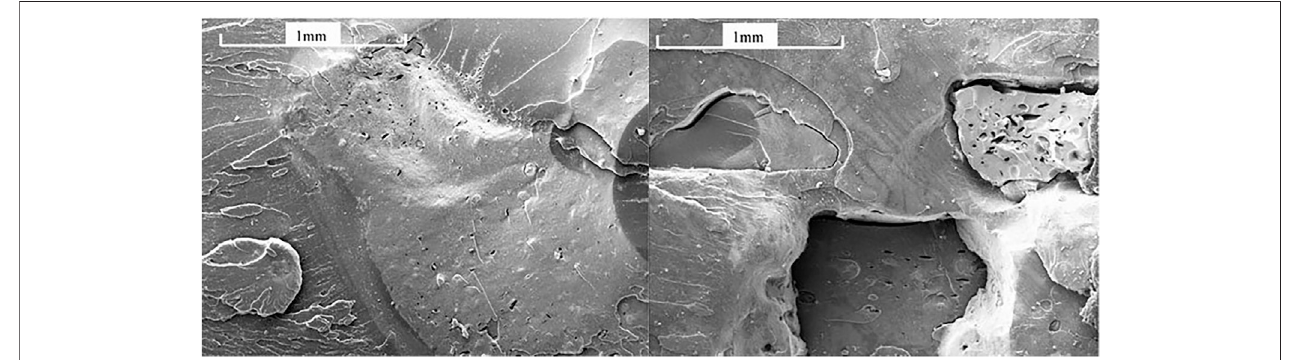
FIGURE 9 | SEM of Dev. R 10 phr tensile fractured surface (A) and Dev. F 10 phr tensile fractured surface (B) .